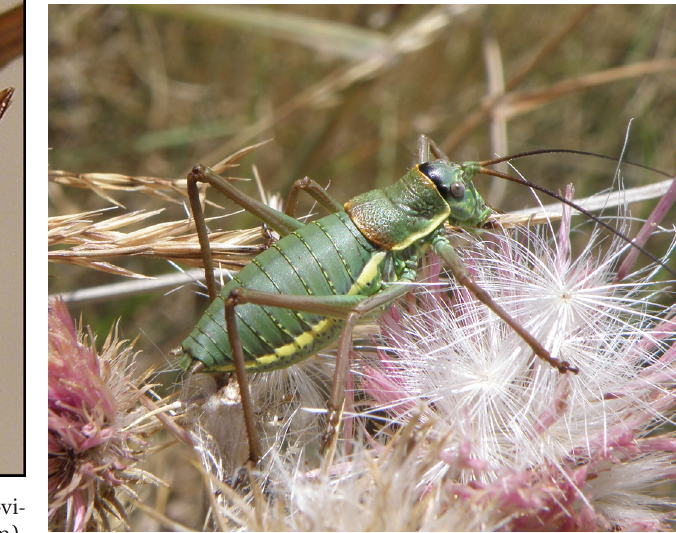
Figure 9. Ephippiger ephippiger ephippiger , male, Macedonia, Mt. Pangeo, 7 VIII